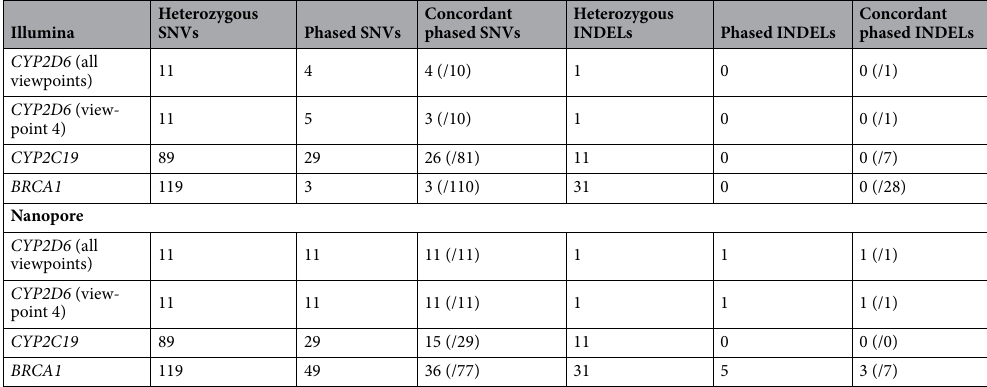
Table 5. Overview of the heterozygous variants in the reference set of Krusche et al. 23 and the phased variants in the Illumina and Nanopore datasets for the studied genes. Concordantly called variants are shown between brackets. The upper part shows the number of variants phased in the Illumina datasets, and the lower part shows the number of variants phased in the Nanopore